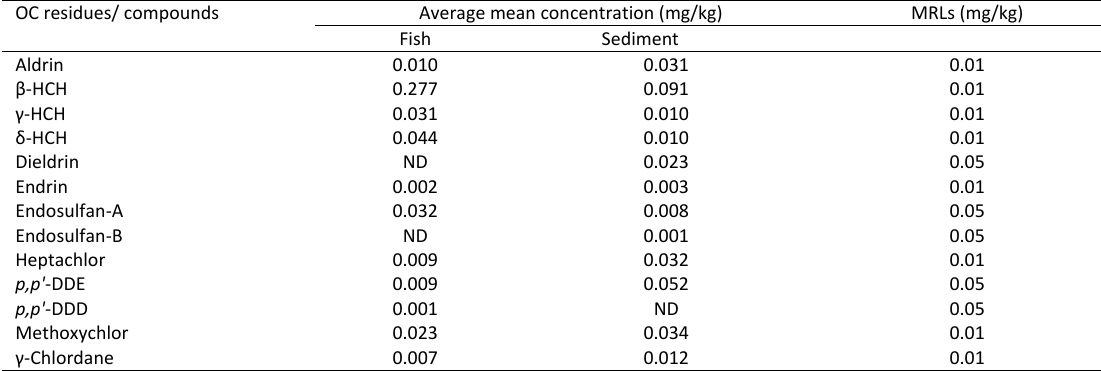
Table 3: Average mean OC residual levels in fish and sediment in relation to their MRLs OC residues/ compounds Average mean concentration (mg/kg)